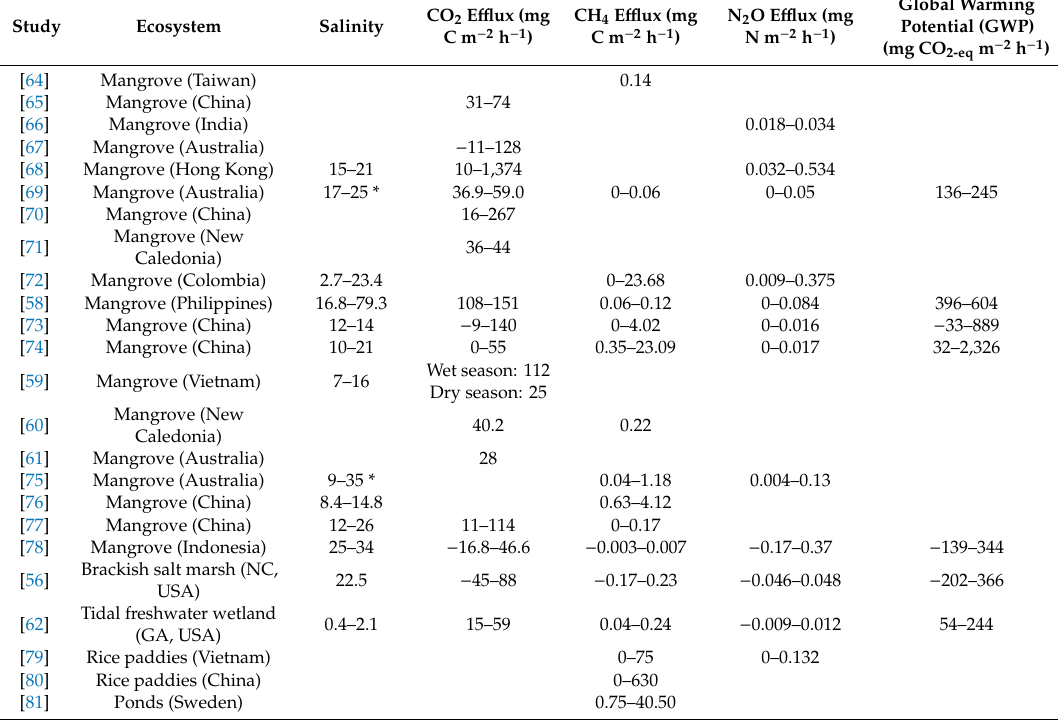
Figure 1. Possible pathways for CO 2 and CH 4 emissions from mangrove forests (modified from Vepraskas and Craft [63]). The black arrows indicate the C pathways. The blue arrows indicate the direction in which increases in environmental factors (salinity, pH) may affect the C pathways. Table 2. Comparison of greenhouse gas effluxes across various salinity ranges. (The absence of data means that the study analyzed did not report these data.)